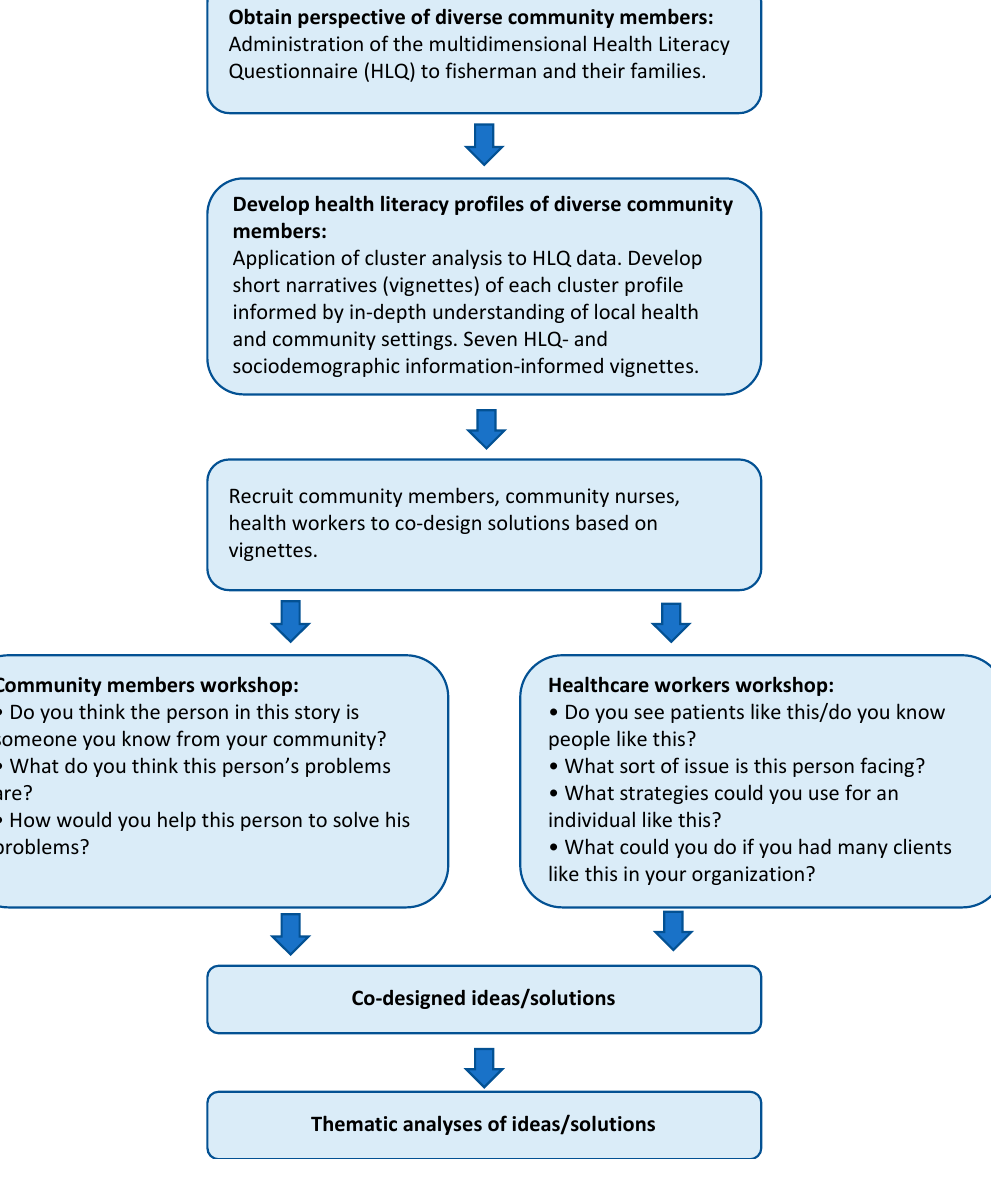
Figure 1. Study process.